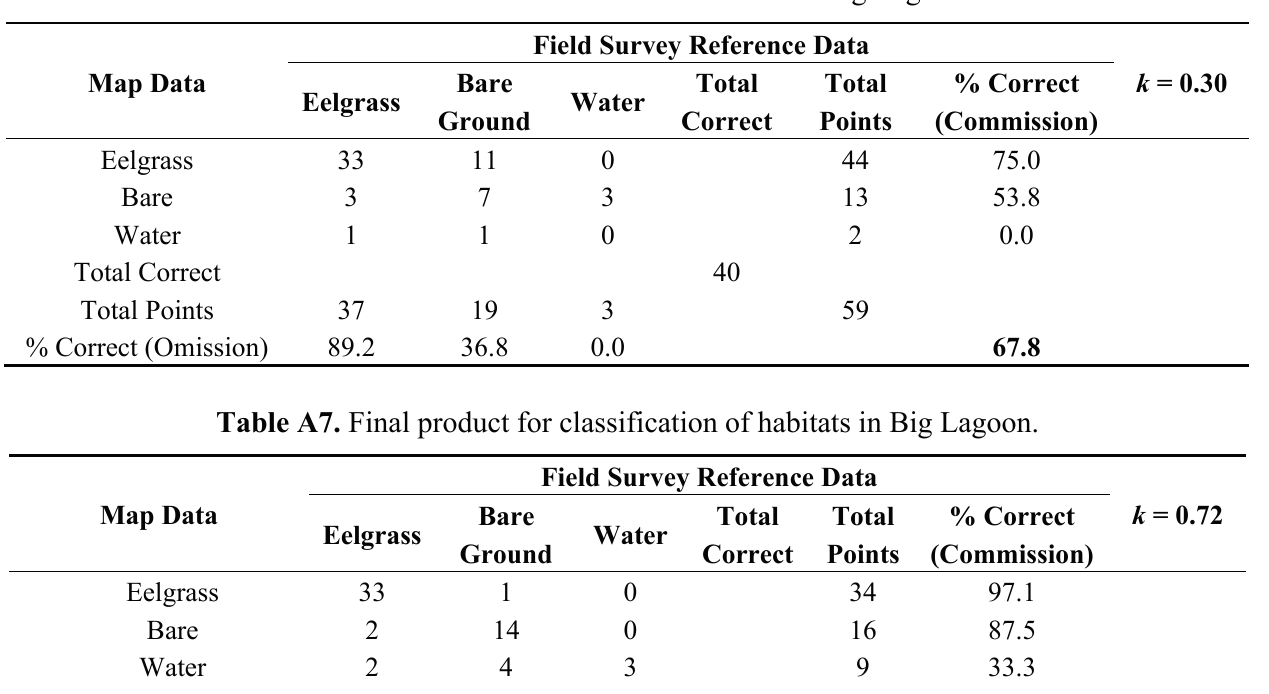
Table A6. Initial classification of habitats in Big Lagoon.